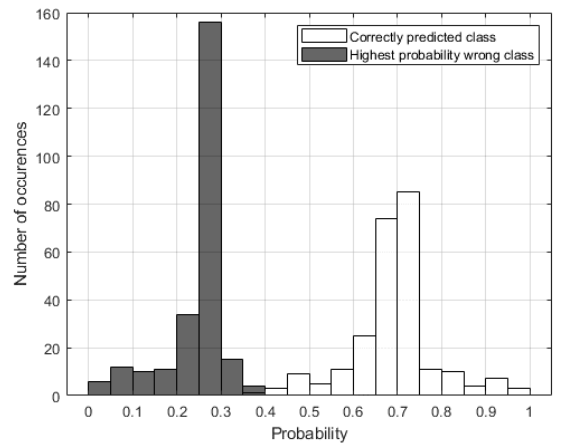
Figure 8. Histogram for estimated probability for the correctly classified events using the linear SVM classifier with feature selection.